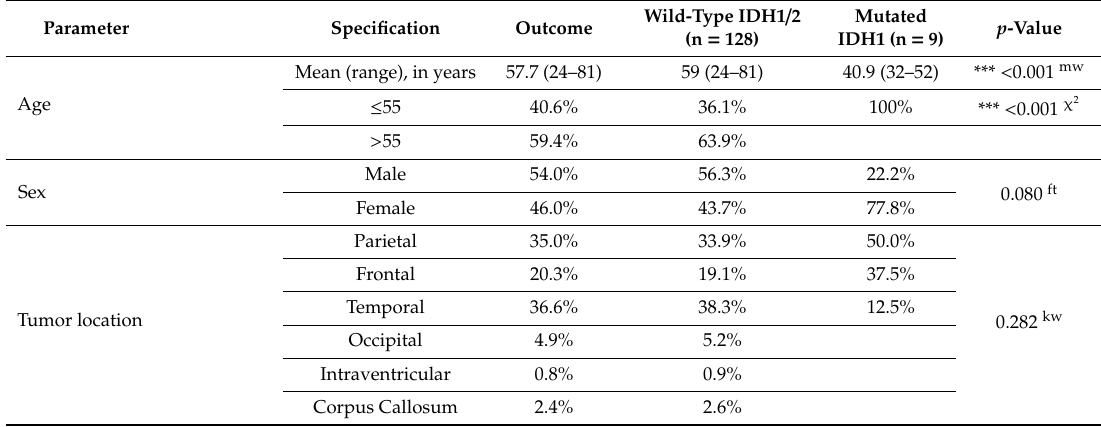
Table 1. Clinical data and baseline molecular characteristics of 137 glioblastoma